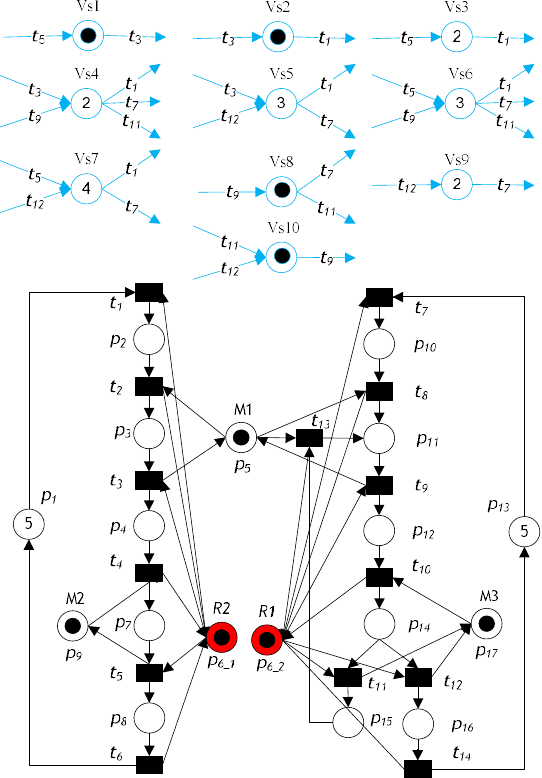
Figure 11. Controlled reconfigurable S 3 PR net by rework.